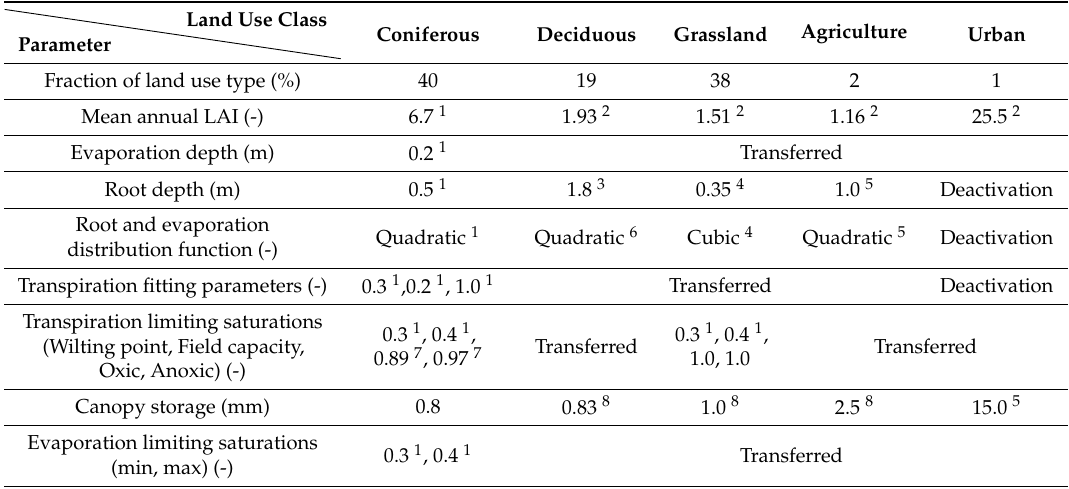
Table 2. Land use parameters used in the Erkensruhr simulation